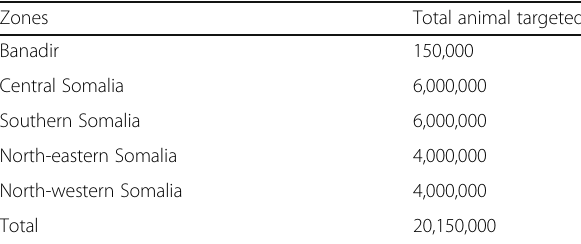
Table 1 Number of sheep and goats targeted during PPR vaccination campaign in Somalia 2012